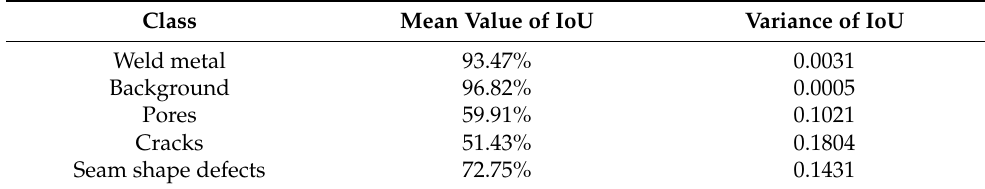
Table 9. Comparison of five classes with image resolution 1024 × 512 based on 57